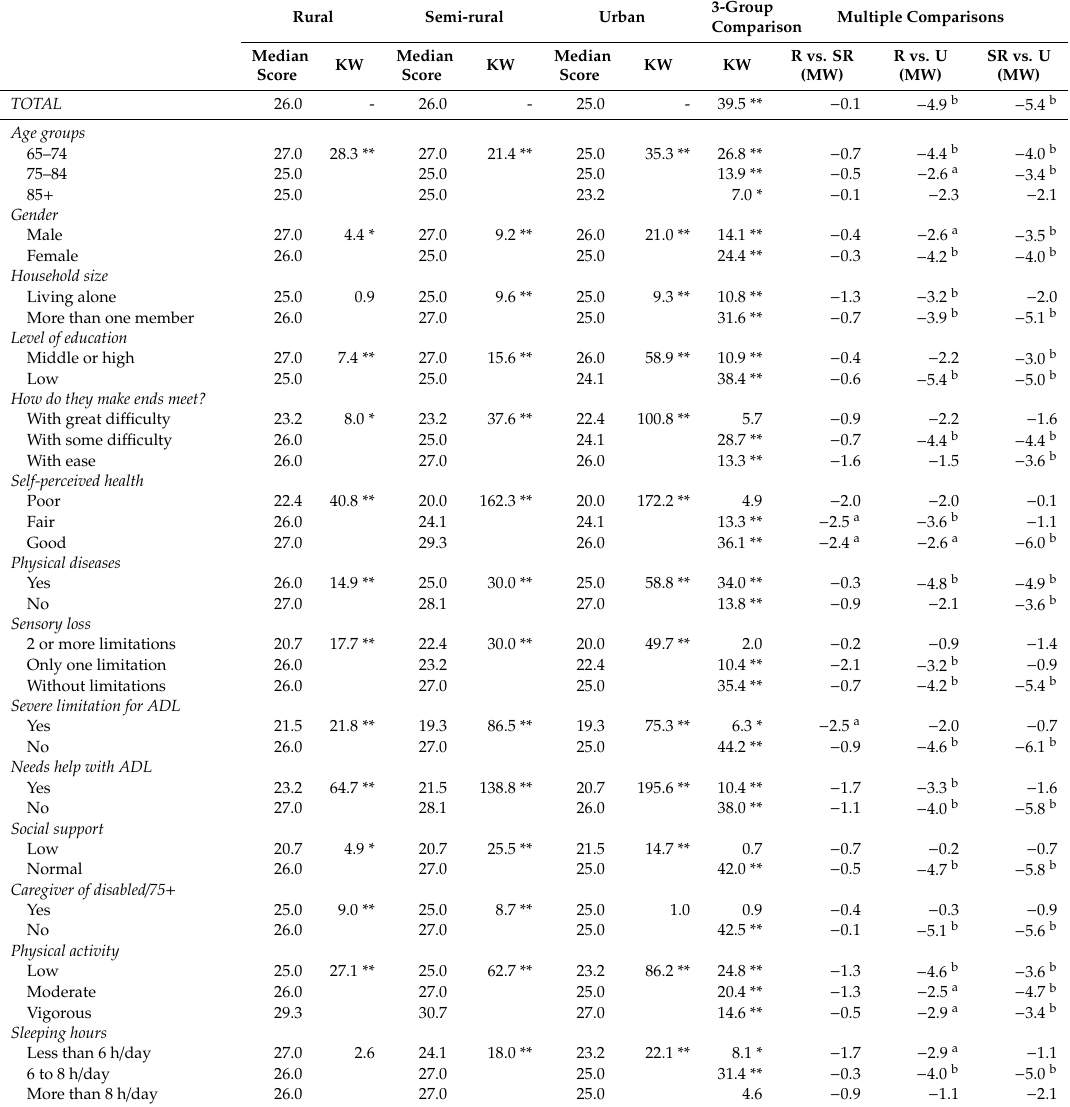
Table 3. SWEMWBS scores by risk factor and level of